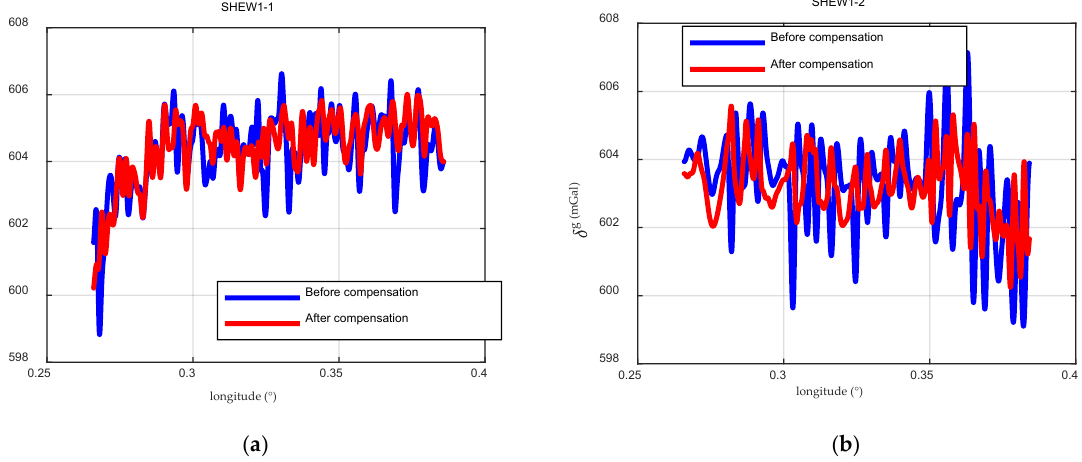
Figure 6. Gravity-measurement result curves for survey line SHEW1 before and after compensation (300 s filtering). ( a ) Gravity-measurement results for survey line SHEW1−1 before and after compensation; ( b ) gravity-measurement results for survey line SHEW1-2 before and after compensation.